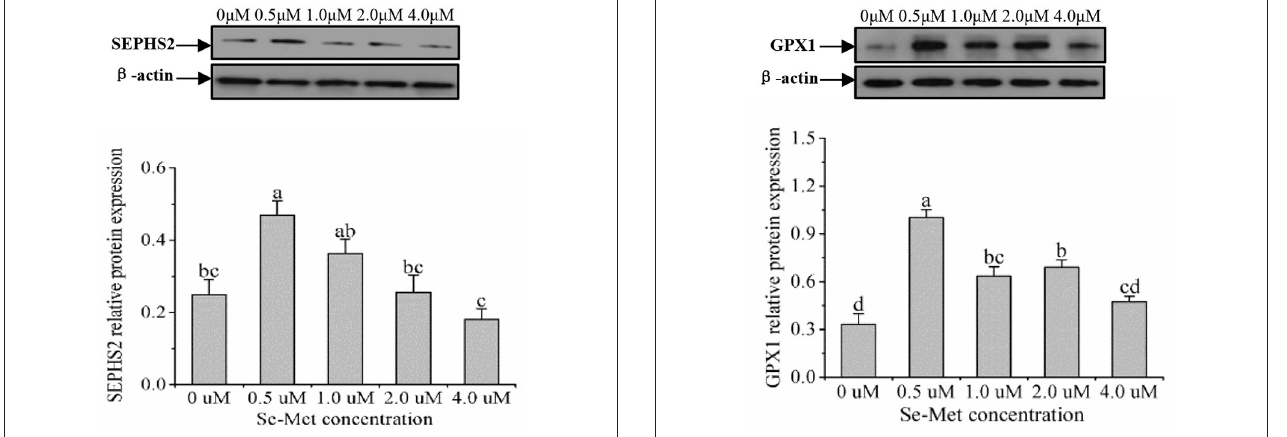
FIGURE 6 | Effects of selenomethionine (Se-Met) supplementation on GPX1 protein expression in porcine mammary epithelial cells (pMECs). The cells were incubated for 48h with different concentrations of Se-Met (0, 0.5, 1, 2, and 4 µ M) and then collected for the determination of protein expression. The data are expressed as the mean ± SEM ( n = 3). Different superscript letters indicate a significant difference ( p < 0.05).